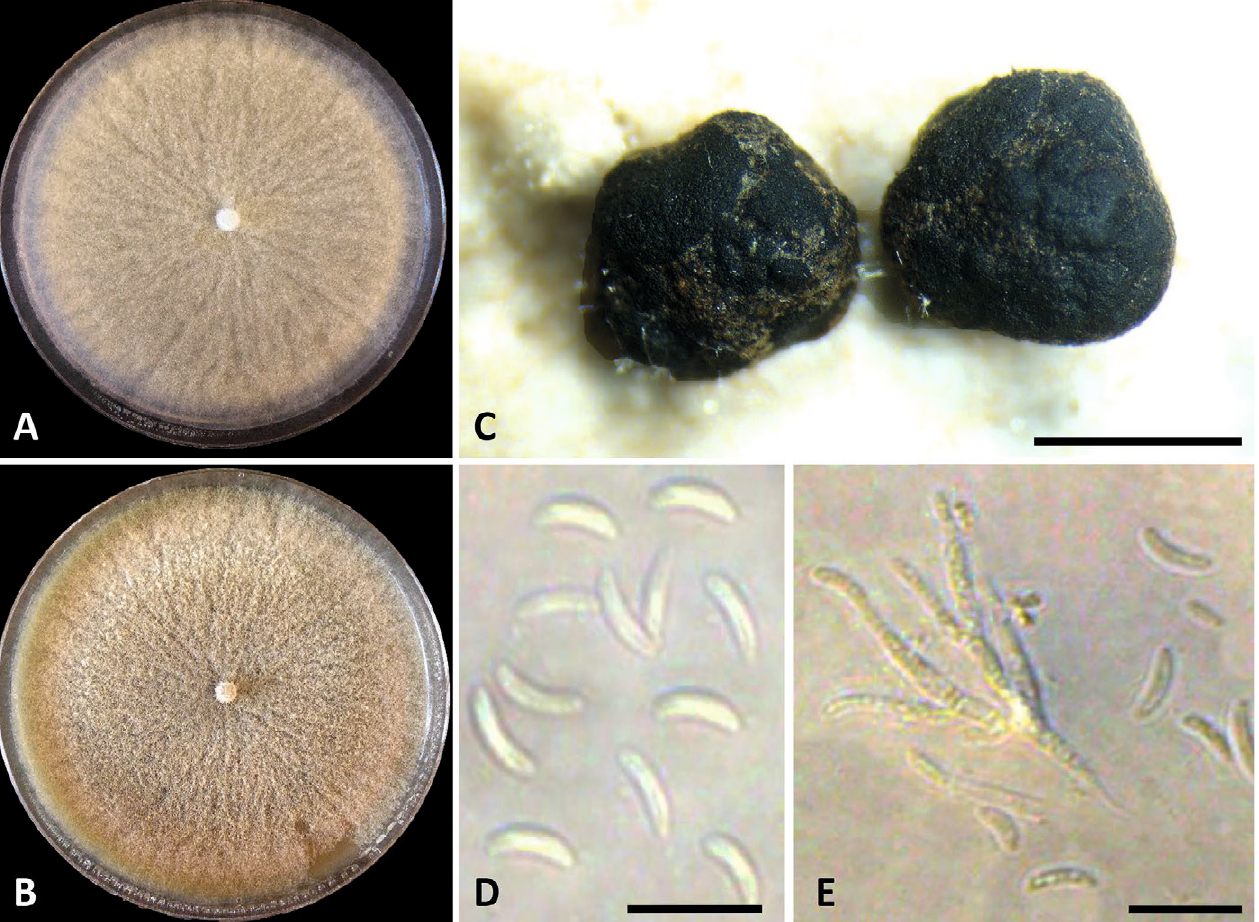
Fig. 8. Cytospora eucalypti (CBS 144241). A. Seven-day-old PDA culture. B. Fourteen-day-old PDA culture. C. Pycnidia. D. Conidia. E.